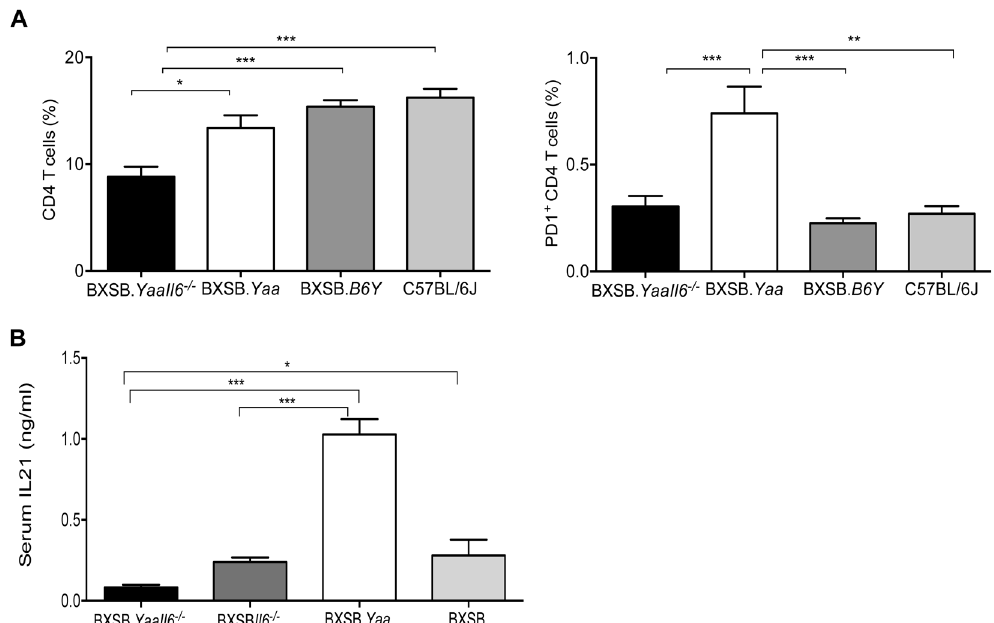
Fig 6. IL6 deficiency reduces the T FH population in BXSB. Yaa mice. (A) Splenocytes from BXSB. Yaa . Il6 -/- (n = 8) BXSB. Yaa (n = 5), BXSB.B6Y (n = 6) and C57BL/6J (n = 3) mice aged 6 – 9 weeks were stained with labeled antibodies to CD4, ICOS and PD1. Percentages of CD4 + T cells (CD4 + ) and T FH cells (CD4 + ICOS hi PD1 + ) cells were determined by FACS and expressed as mean ± SEM. (B) Sera from BXSB. Yaa . Il6 -/- (n = 12; 1.5 – 5 months old), BXSB. Il6 -/- (n = 5; 3 – 5 months old); BXSB. Yaa (n = 5; 3 – 5 months old) and BXSB (n = 5; 3 – 5 months old) mice were quantified for IL21 by sandwich ELISA. Data is expressed as mean ± SEM from observations from each mouse. Statistical analysis was done using one-way ANOVA with Tukey ’ s multiple comparison test. * p < 0.05, ** p < 0.01, *** p <